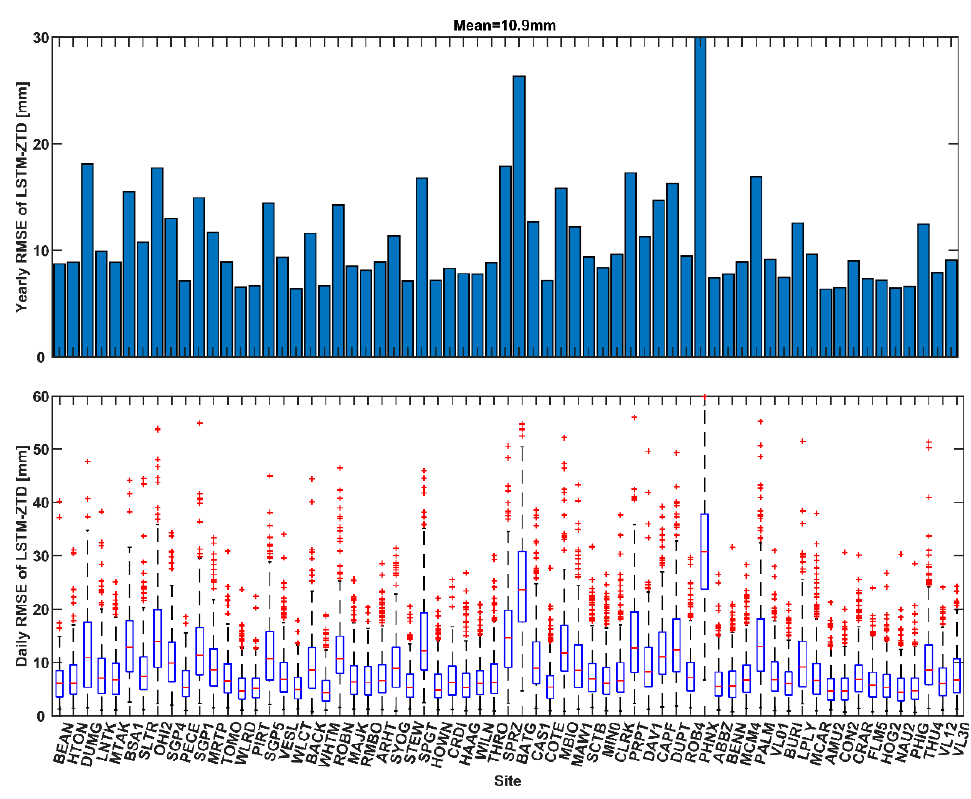
Figure 13. Yearly RMSE and daily RMSE of LSTM_ZTD in the forecast period at 65 stations. Table 2. Statistical result of piece-wise yearly RMSE and percentage of daily RMSE for 65 stations.